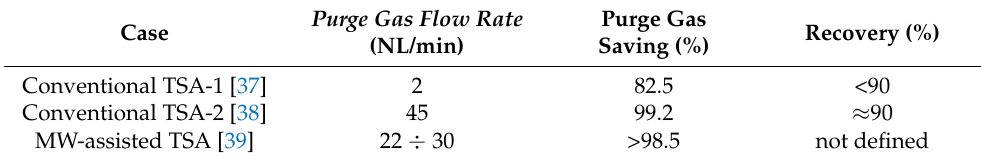
Table 9. Comparison Table 2—other